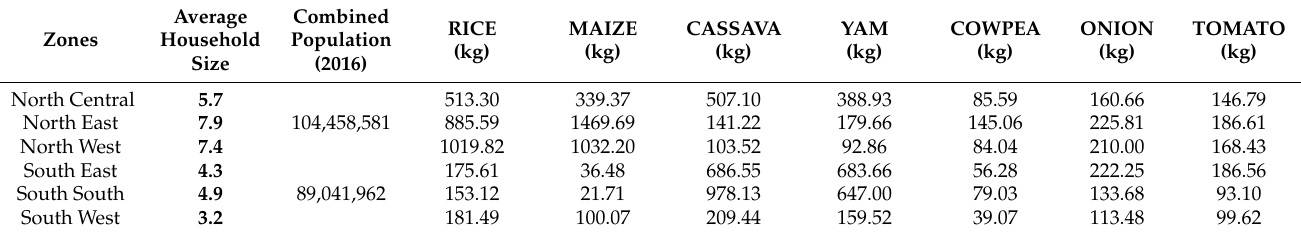
Table 3. Total per annum household food quantity consumption in the six geopolitical